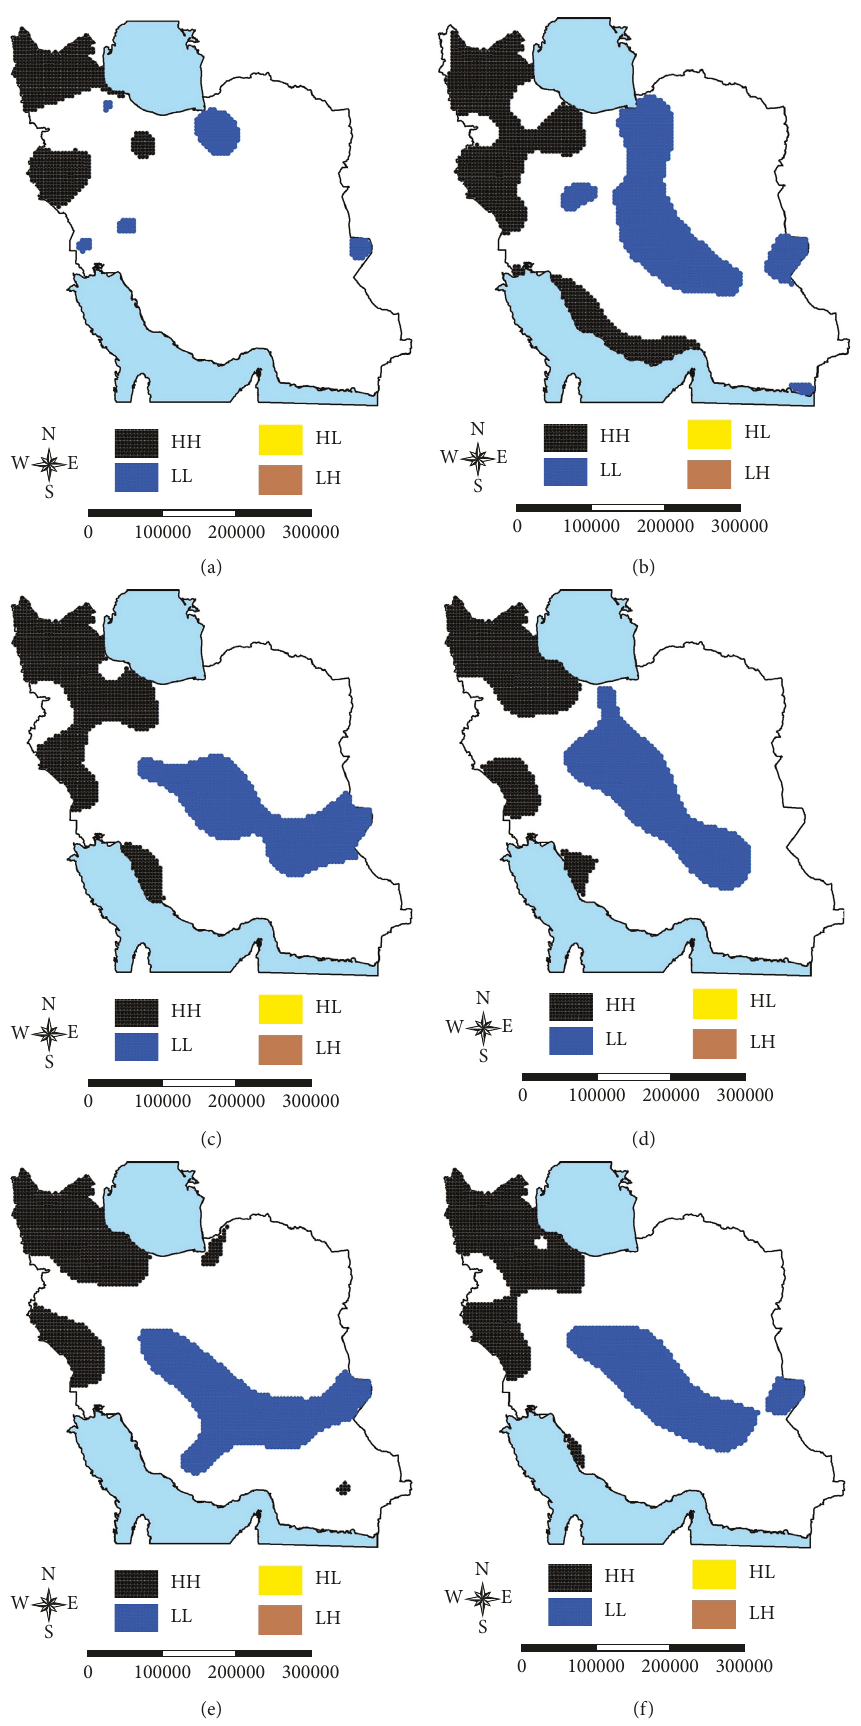
Figure 3: Spatial distribution of autocorrelation pattern of Iran’s thunderstorms based on Moran’s I 2 . (a) 1961–1970, (b) 1971–1980, (c) 1981–1990, (d) 1991–2000, (e) 2001–2010, and (f)